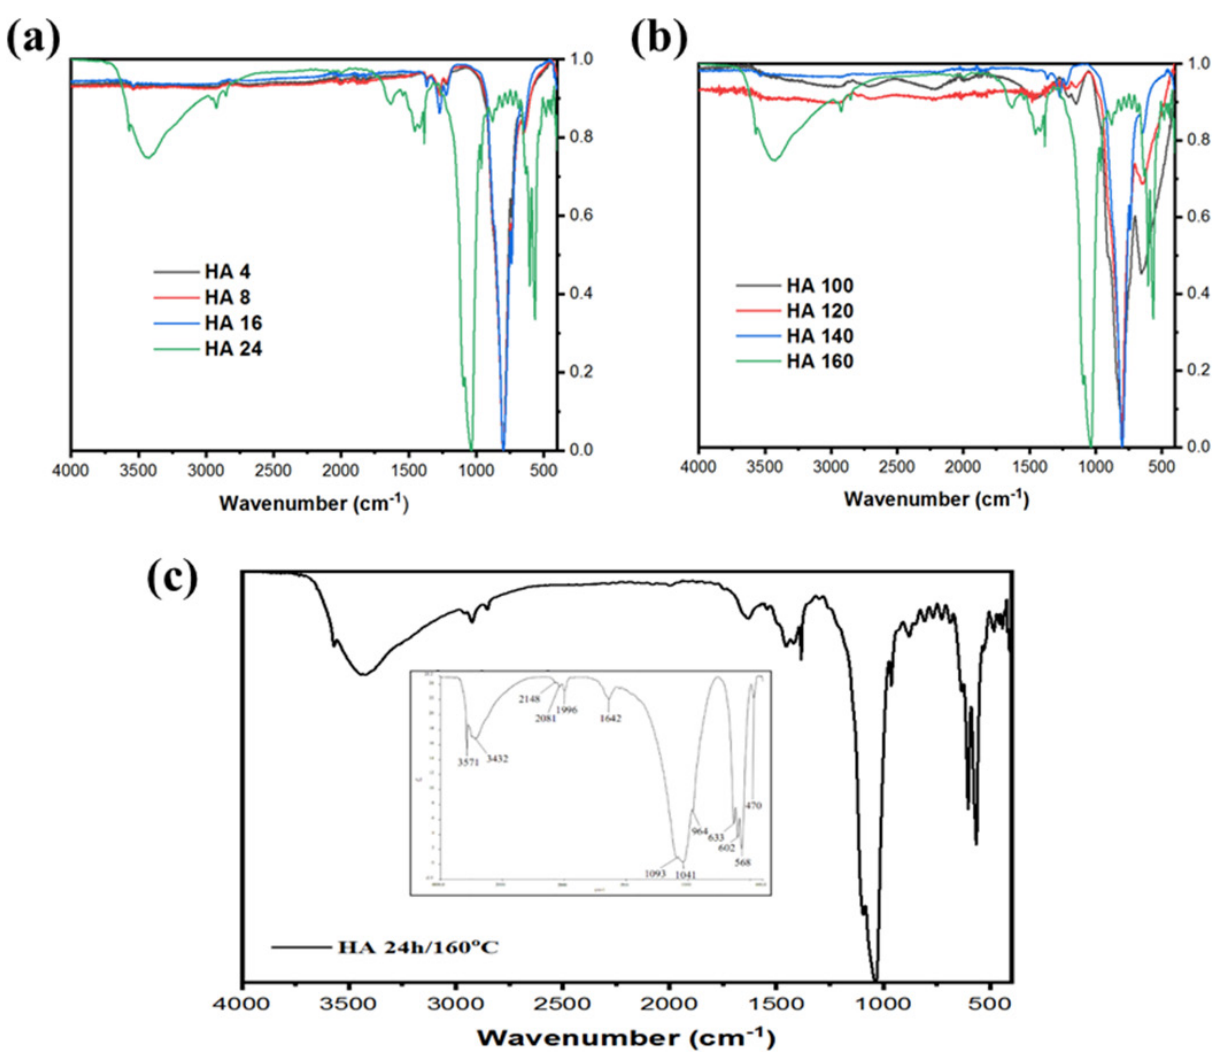
Figure S1: FT-IR spectra of the synthesized nano-hydroxyapatite prepared by the various conditions in the hydrothermal route: (a) Role of dwell time, (b) Effect of temperature and (c) The optimized ideal conditions as comparable to the reference reported in literature